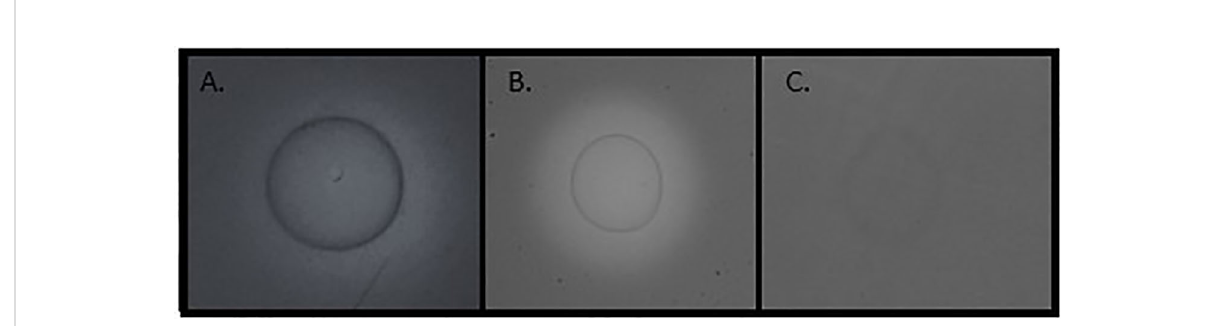
FIGURE 1 Degradation of carboxymethylcellulose (CMC) on CMC agar plates by bacterial lysate. Overnight grown cultures were sonicated and centrifuged, and the supernatant was spotted on CMC agar plates. The plates were stained with 0.1% Congo red and washed with 1M NaCl. Bright halos indicate CMC degradation. (A) Bacterial lysate of S . Typhimurium (w.t.), a light halo is observed, circulating the bacterial lysate. (B) Bacterial lysate of S . Typhimurium pBcsZ (overexpressing BcsZ), a bright and strong halo is observed (C) Bacterial lysate of S . Typhimurium D BcsZ (lacking the ability to produce BcsZ), no halo is